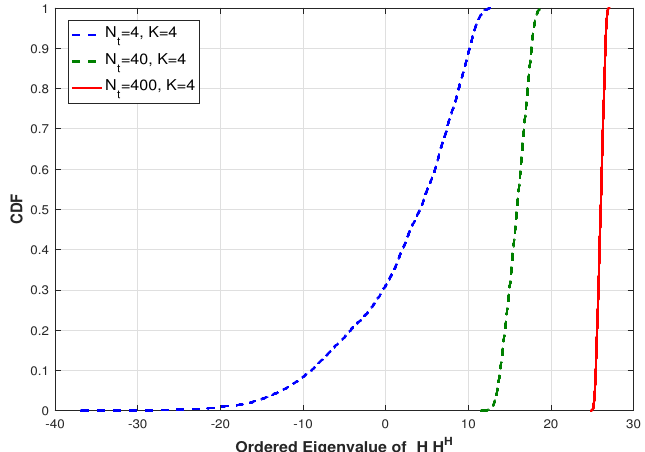
Figure 3. Channel hardening effect, when N t = 4, 40, 400 and K =